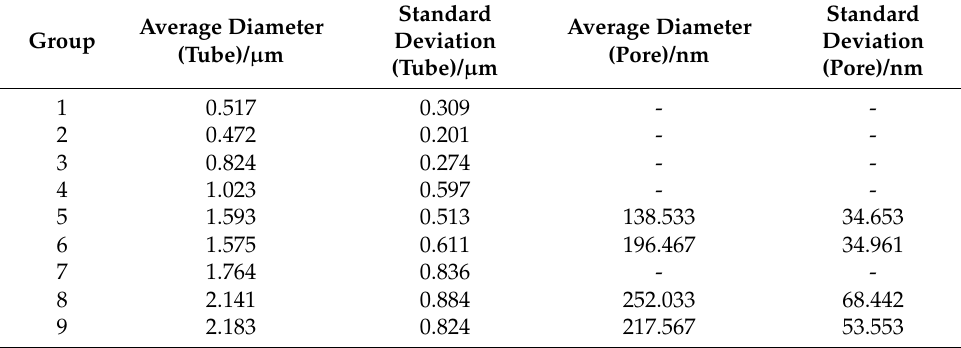
Table 2. Fiber diameter and pore size.